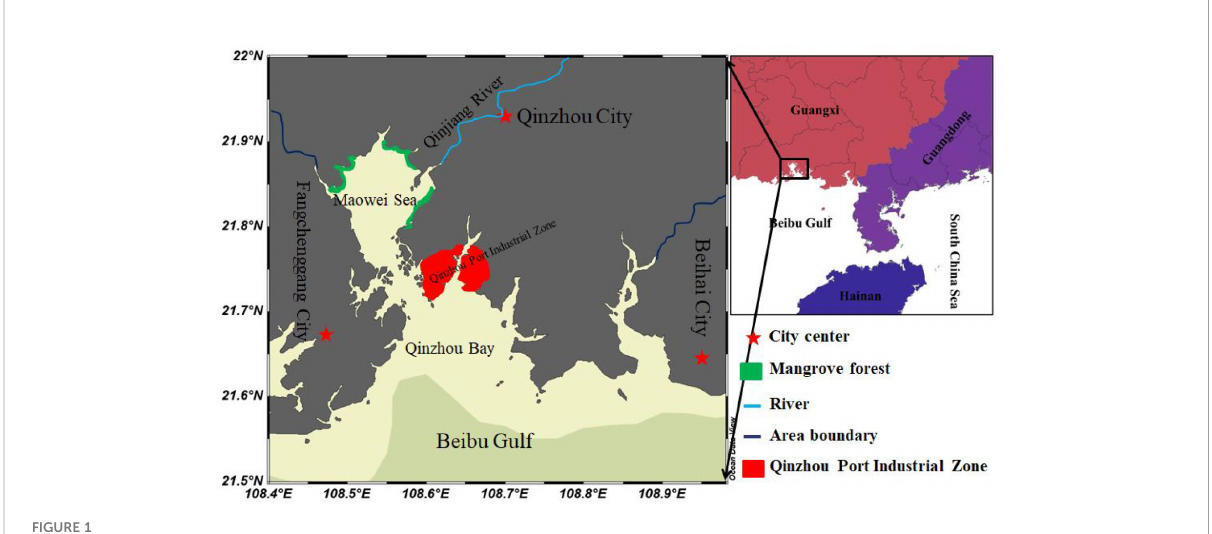
FIGURE 1 Map showing the geographical location of the study